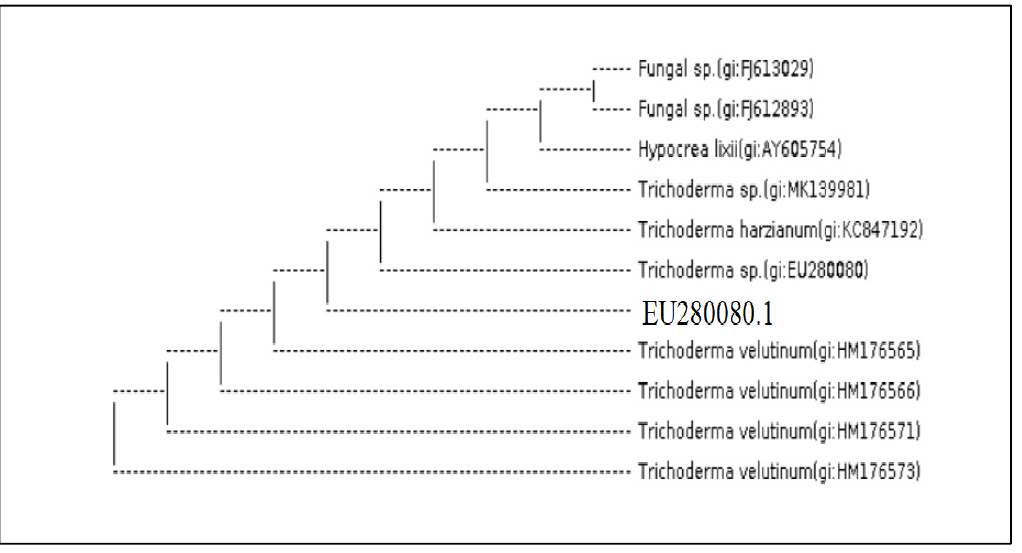
Figure 5. Trichoderma isolate (A (6) 2.2 T) (analysis of 18S rDNA of the T. velutinum (EU280080.1), with primers ITS4 and ITS5 in NCBI GenBank